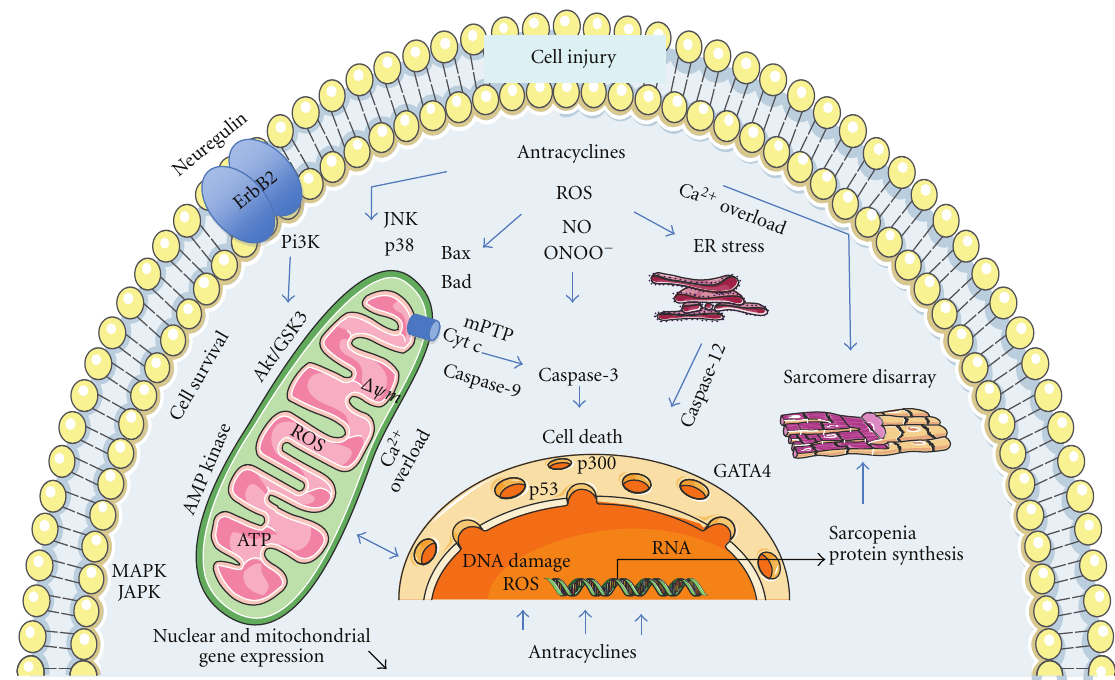
Figure 1: Potential signaling pathways involved in anthracycline-induced cardiomyocyte injury. Anthracycline-induced cell death is balanced by intracellular survival signaling which is linked to neuregulin/ErbB2 and Akt activation. The suggested principal mechanism of anthracycline damage is via generation of reactive oxygen species ROS by iron-anthracycline complexes, leading to lipid peroxidation and membrane damage. Oxidative stress (ROS, nitric oxide NO, and peroxynitrite ONOO–) causes activation of kinase pathways (mitogen- activated protein kinase MAPK, stress-activated protein kinase SAPK, c-Jun N-terminal kinases JNK) modulating response to anthracyclines and linking to apoptotic pathway. In mitochondria, ROS and calcium overload lead to the release of cytochrome c (cyt c) from mitochondria into cytoplasm, via mitochondrial permeability transition pore opening (mPTP), which results in membrane potential dissipation (delta psi m), activation of caspases and apoptosis. Other putative mechanisms include damage to nuclear DNA, disruption of sarcomeric protein, suppression of transcription factors (GATA-4, p300, p53) that regulate cell survival and sarcomeric protein synthesis, and disturbance of energy